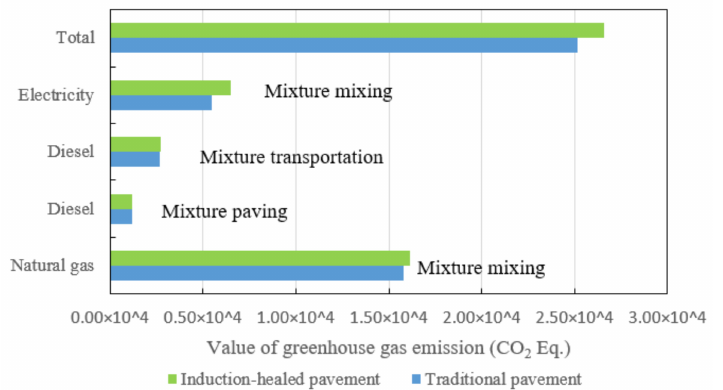
Figure 11. Greenhouse gas emissions comparison of two asphalt pavements’ paving stages. Similar to the energy consumption in the maintenance stage, the equivalent CO 2 emissions of the traditional pavement is still higher than that of the